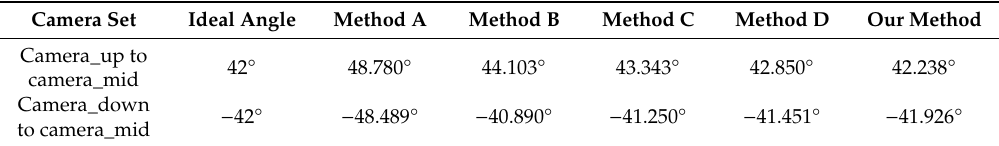
Table 5. Angle between multiple depth cameras of the five calibration methods.